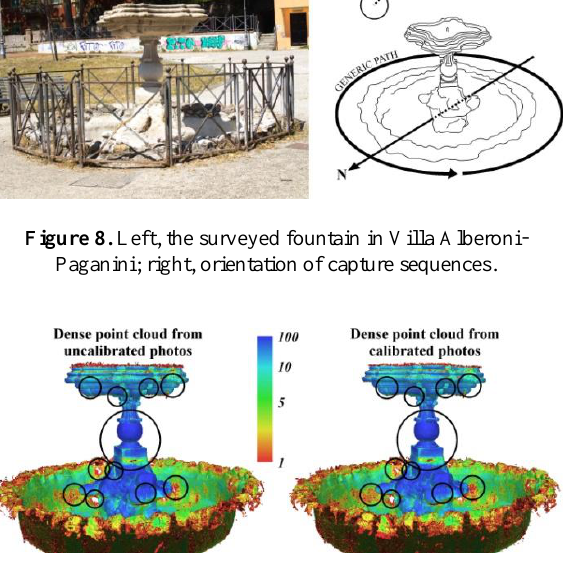
Figure 9. Reliability comparison between the dense point clouds of the fountain. Improved parts are circled in black.